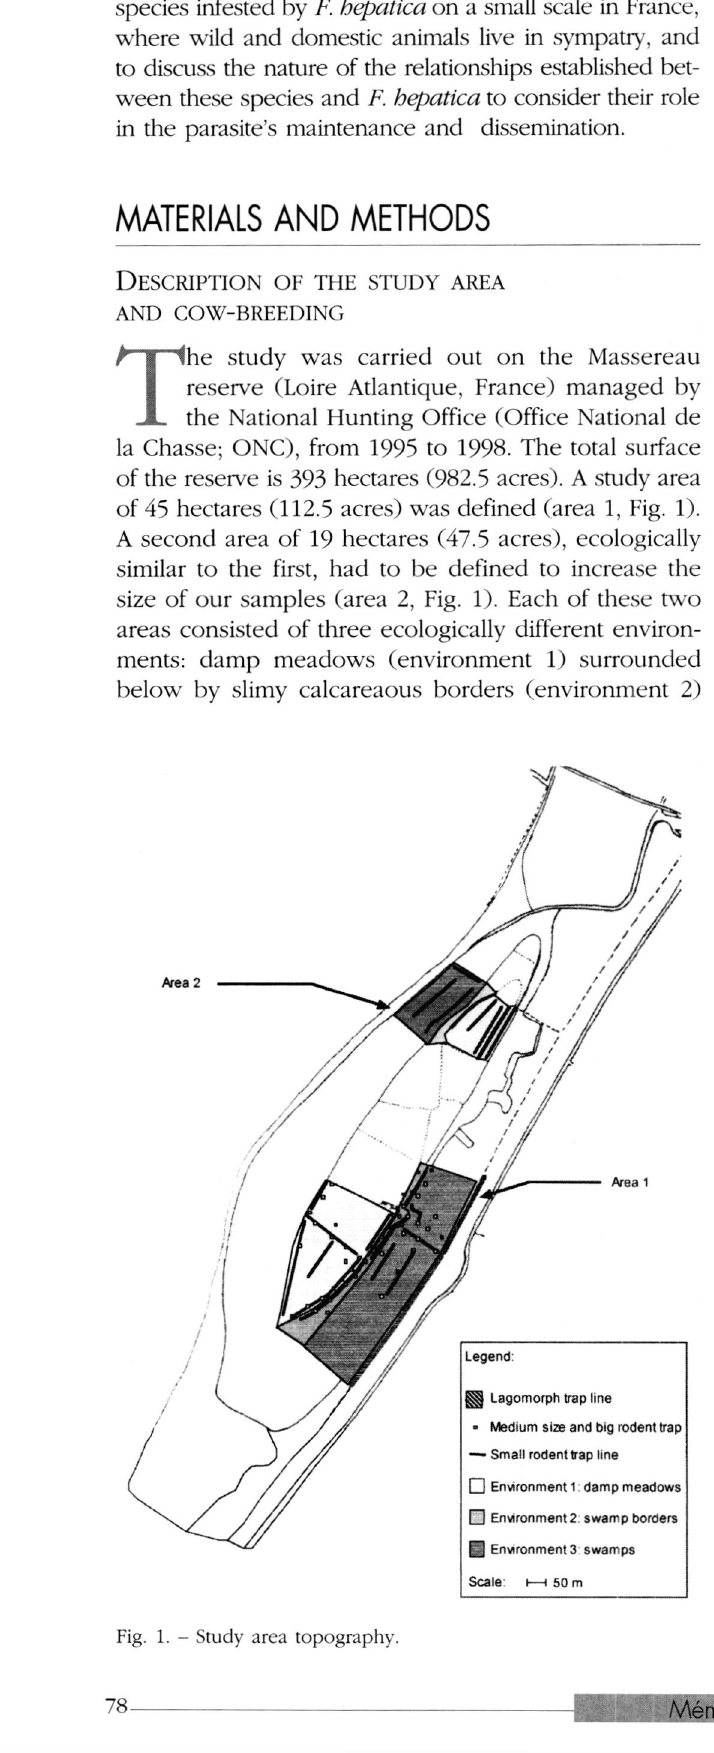
Fig. 1. - Study area